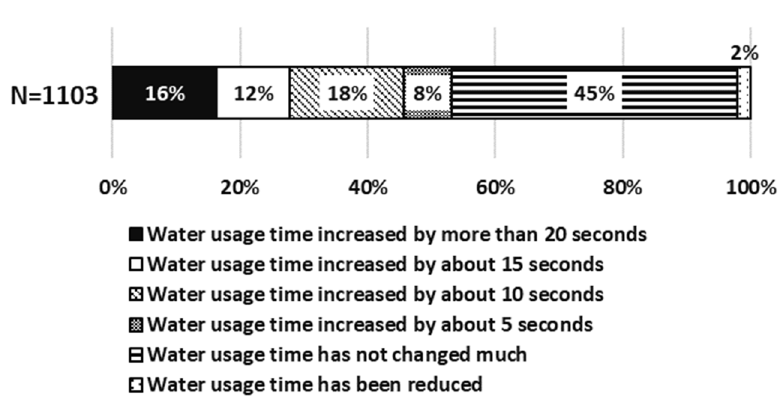
Figure 5. Daily hand and face washing frequency before and during the coronavirus pandemic.